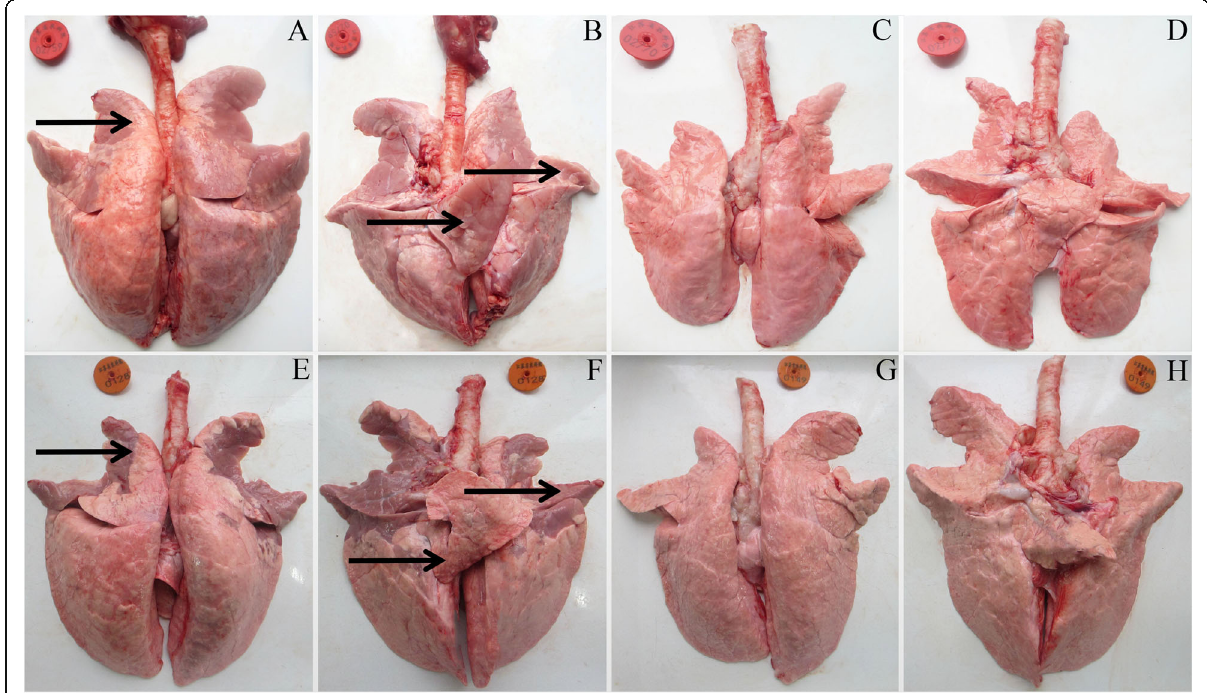
Fig. 1 Gross lesions evaluation of lung samples at 28 dpi after necropsy. Whole lung samples connected to the trachea of each piglet were imaged after the animals were sacrificed. a and b Dorsal and ventral views of representative morphology images of lung gross lesions in the M. hyopneumoniae strain JS-infected group of the Bama miniature pigs; ( c ) and ( d ): Dorsal and ventral views of representative morphology images of lung samples in the control group of the Bama miniature pigs; ( e ) and ( f ): Dorsal and ventral views of representative morphology images of lung gross lesions in the M. hyopneumoniae strain JS-infected group of the conventional pigs; ( g ) and ( h ): Dorsal and ventral views of representative morphology images of lung samples in the control group of the conventional